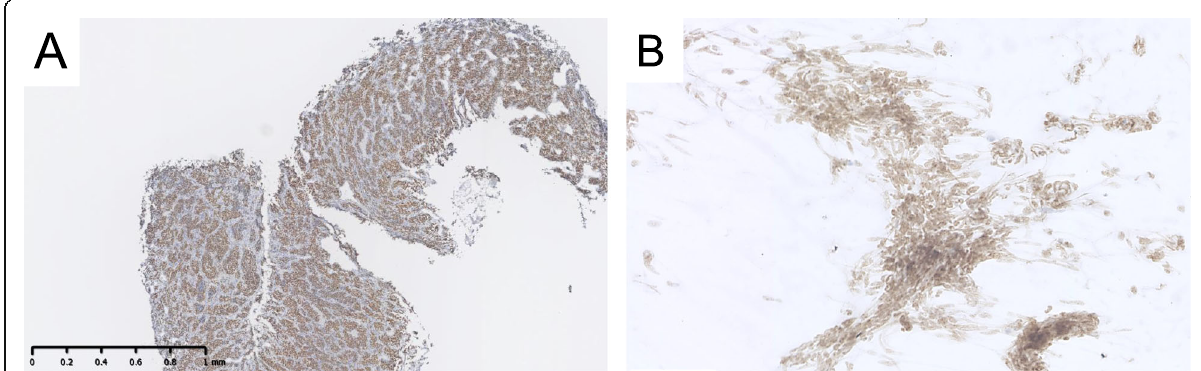
Fig. 5 SS18-SSX immunostaining in the synovial sarcoma: Case 5 (A); intraoperative sealed cytology: Case 3 (B). The image shows strong diffuse nuclear